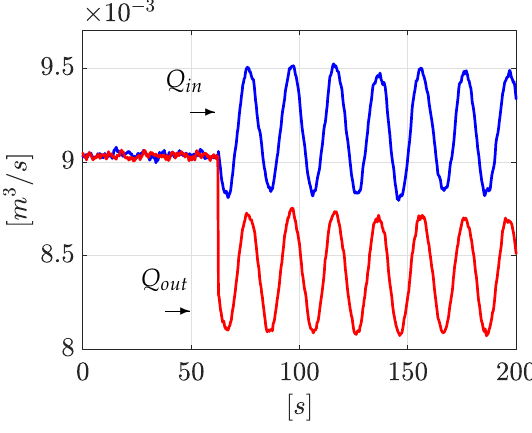
Figure 5. Flow rates Q in and Q out